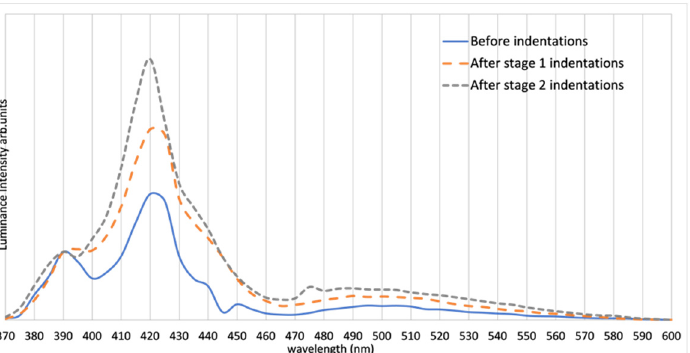
Figure 10. Spectrum of Sample 3 before and after indentation at each stage (normalized at 390 nm).